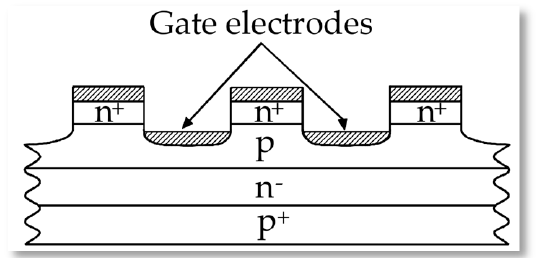
Figure 2. Cross section of a GTO showing the cathode islands and interdigitation with the gate (p-base).